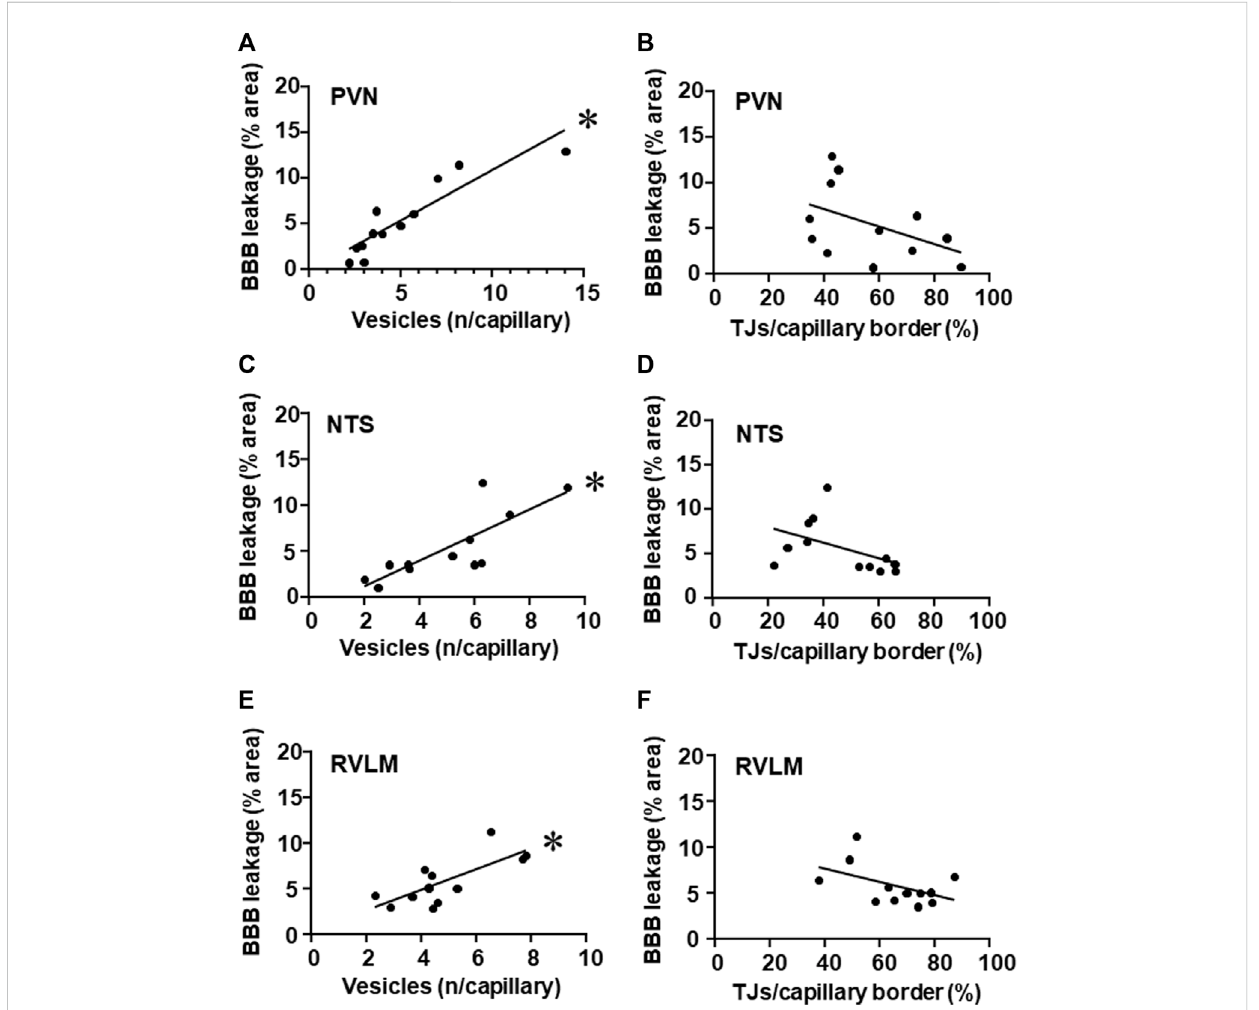
FIGURE 6 Correlations between the number of vesicles/capillary and BBB permeability (A,C,E) and between tight junctions/capillary and BBB permeability (B,D,F) within the PVN (A,B) , NTS (C,D) and RVLM (E,F) of sedentary and trained SHR and Wistar rats. BBB permeability and respective vesicles/capillary values, were obtained in 3 rats/group. Linear regression equations, correlation coef fi cients and p values are: PVN vesicles x BBB permeability Y = 1.10x – 0.16, r =0.905, p < 0.001; NTS vesicles x BBBpermeability Y = 1.40x – 1.66, r = 0.808, p = 0.002; RVLM vesicles xBBB permeability Y = 1.12x + 0.44, r = 0.743, p = 0.006; PVN TJs/capillary border x BBB permeability Y = − 0.10x +10.9, r = − 0.461, p = 0.131; NTS TJs/capillary border x BBB permeability Y = − 0.09x +9.7, r = − 0.469, p = 0.124; RVLM TJs/capillary border x BBB permeability Y = − 0.07x +10.7, r = − 0.479, p = 0.229. * denotes a signi fi cant